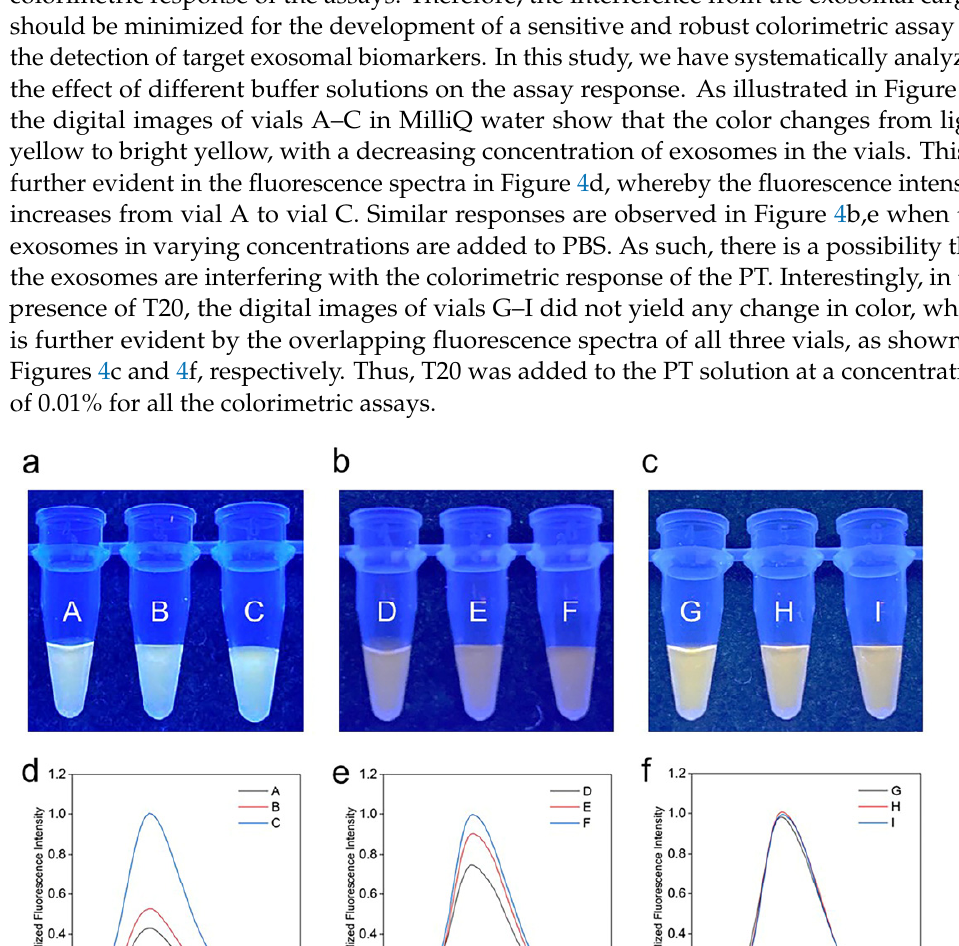
Figure 5. Melting curve of mir21 expression (20 cycles).